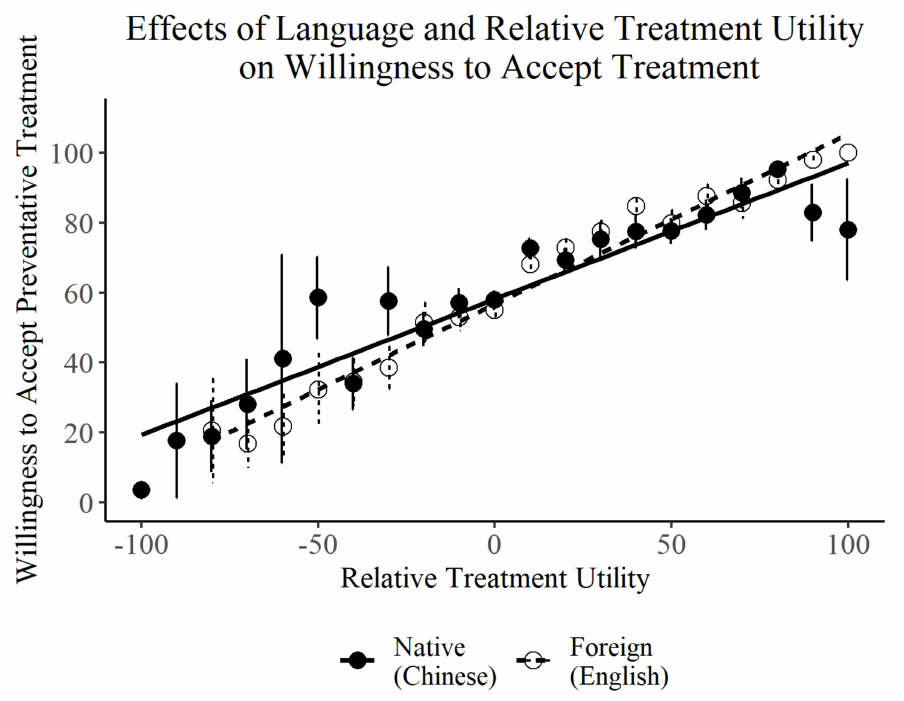
Figure 2. Effects of language and relative treatment utility on willingness to accept preventative treatment. Relative treatment utility was calculated as the expected harm of the disease (disease negativity × disease risk) minus the expected harm of the treatment (treatment negativity × treatment risk). Positive values indicate that the expected harm of the disease exceeded that of the treatment. Willingness to accept treatment increased with greater relative treatment utility, particularly when using a foreign language (dashed, white) compared to a native language (solid, black). Error bars represent standard errors within each 10-point bin from − 100 (treatment harm far exceeds disease harm) to +100 (disease harm far exceeds treatment